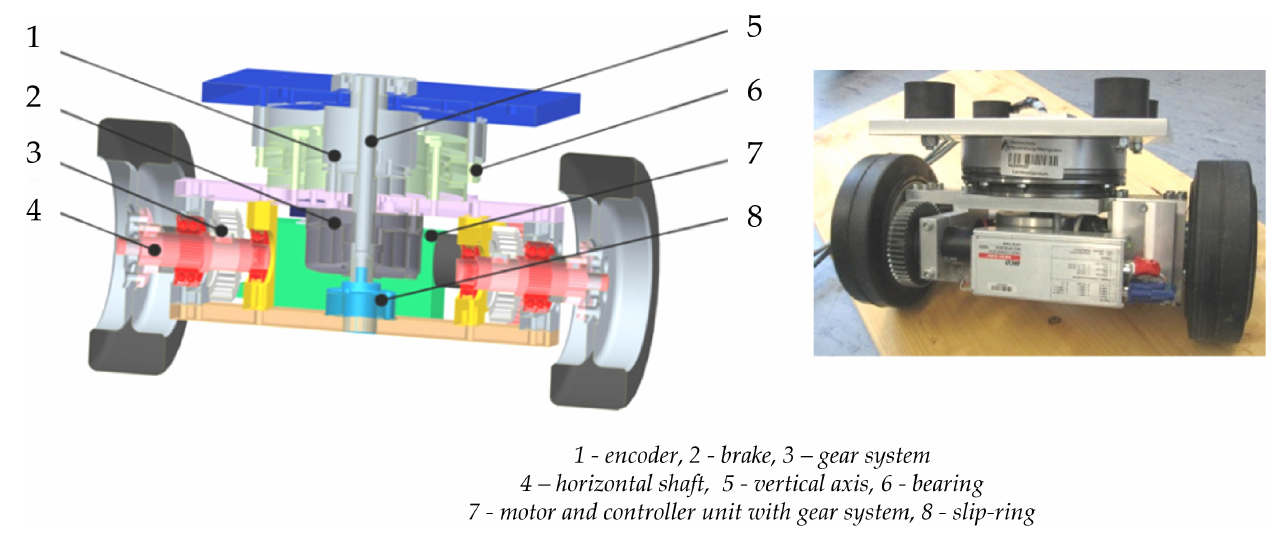
Figure 11. Components of the drive module of the AGV. Another instance of redundancy are the ultrasonic sensors on all sides of the AGV (Figure 12).